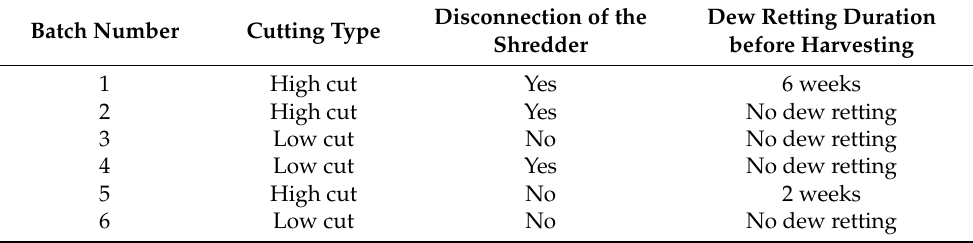
Table 1. Harvesting details of all the batches used in this